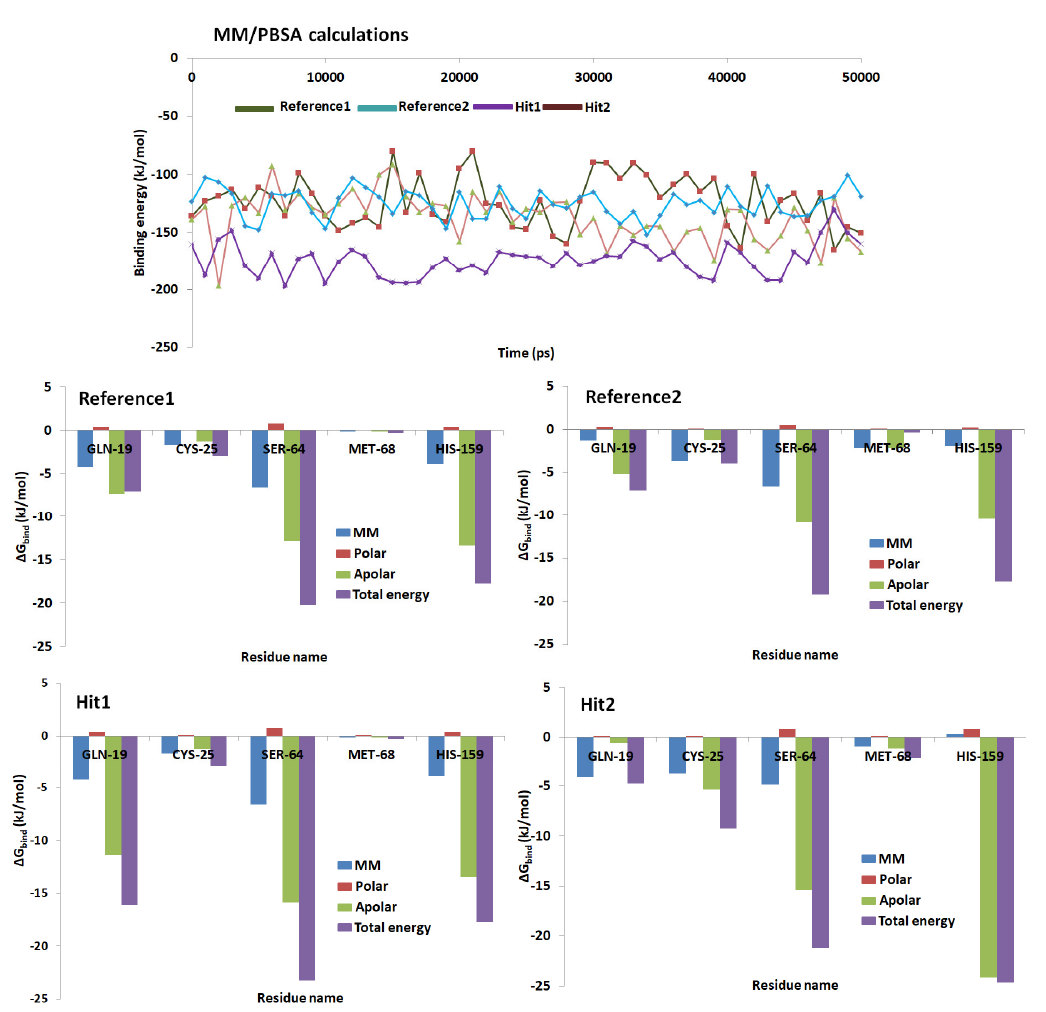
Figure 8. MM/PBSA binding free energy calculations of the Hits and reference compound along with the per-residue